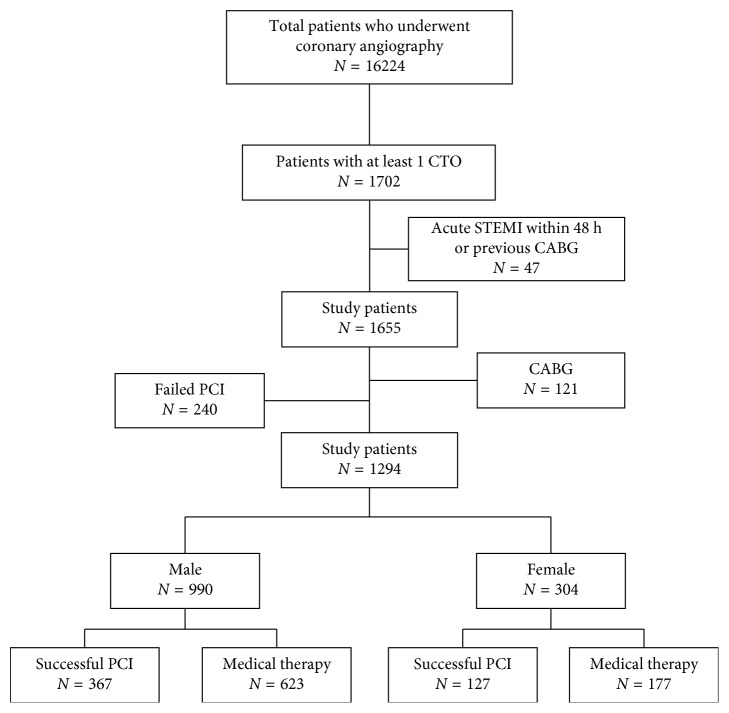
Flow chart of the study population. CABG, coronary artery bypass grafting; CTO, chronic total occlusion; PCI, percutaneous coronary intervention; STEMI, ST-segment elevation myocardial infarction.